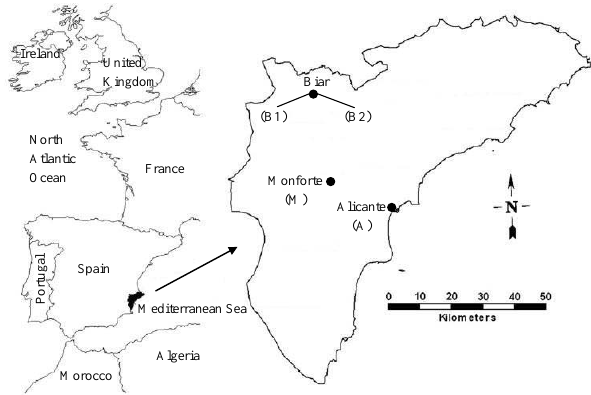
Fig. 1. Location of the study